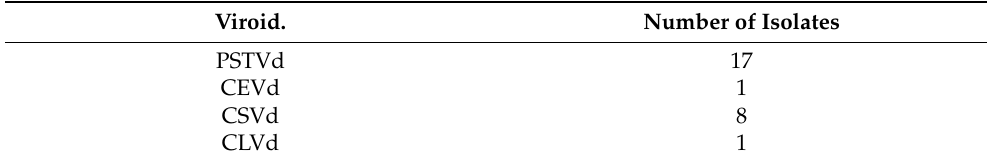
Table 2. Presence of Kozak Frame in Viroid